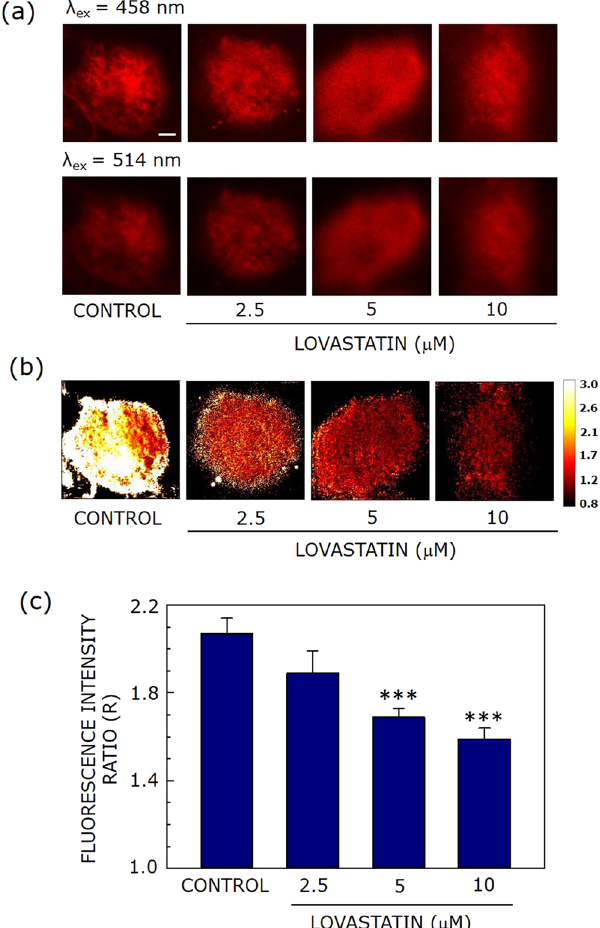
Figure 3. Effect of chronic cholesterol depletion on membrane dipole potential. Representative confocal micrographs of CHO-K1 cells labeled with di-8-ANEPPS ( λ ex = 458 nm (upper panel), and λ ex = 514 nm (lower panel), the emission band pass being 650–710 nm in both cases) with increasing concentrations of lovastatin. Fluorescence intensity of images was corrected for laser power at two different excitation wavelengths (458 and 514 nm). ( b ) The corresponding fluorescence intensity ratio (R) map (color coded in a scale of 0.8–3) under these conditions. R is defined as the ratio of fluorescence intensities at an excitation wavelength of 458 nm to that at 514 nm (emission band pass at 650–710 nm in both cases) and was calculated using ImageJ (NIH, Bethesda, MD). ( c ) Effect of increasing lovastatin concentration on the R value (means ± S.E.), averaged over at least fifteen independent measurements ( *** corresponds to significant ( p < 0.001) difference in R). The scale bar indicates 10 μ m. See Methods for more